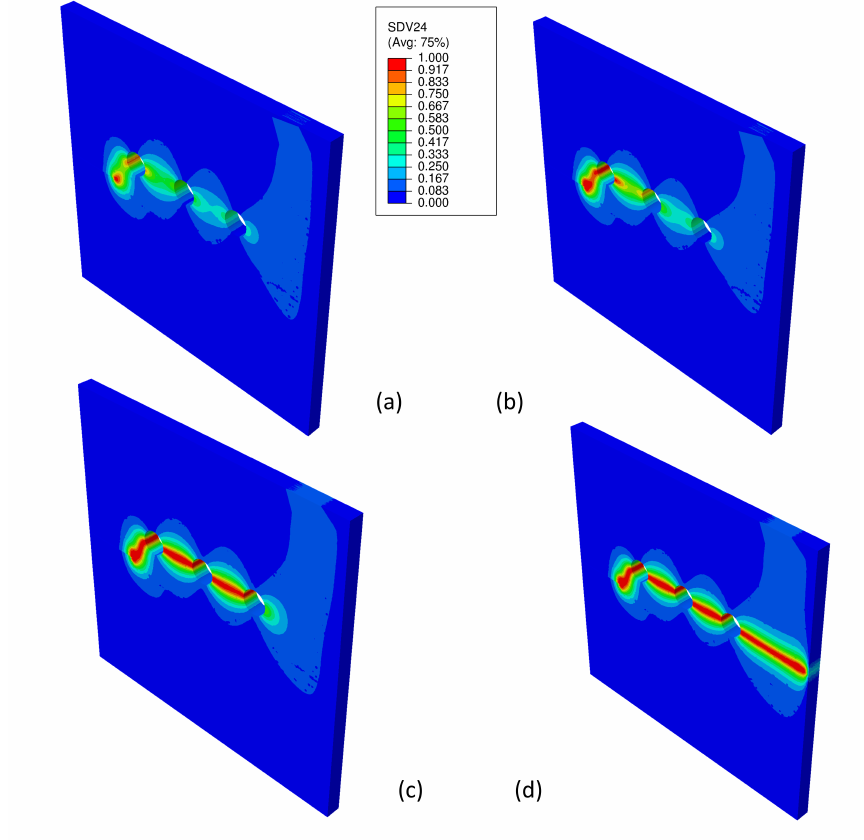
Figure 10. Crack propagation steps: ( a ) crack propagation begins ( b ) crack arrest due to damage from opening; ( c ) crack propagates through the openings; and ( d ) crack continues in the previous